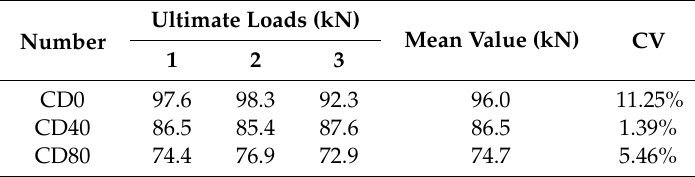
Figure 9. The load-displacement curves of all types of specimens. Table 6. The ultimate loads of various specimens.